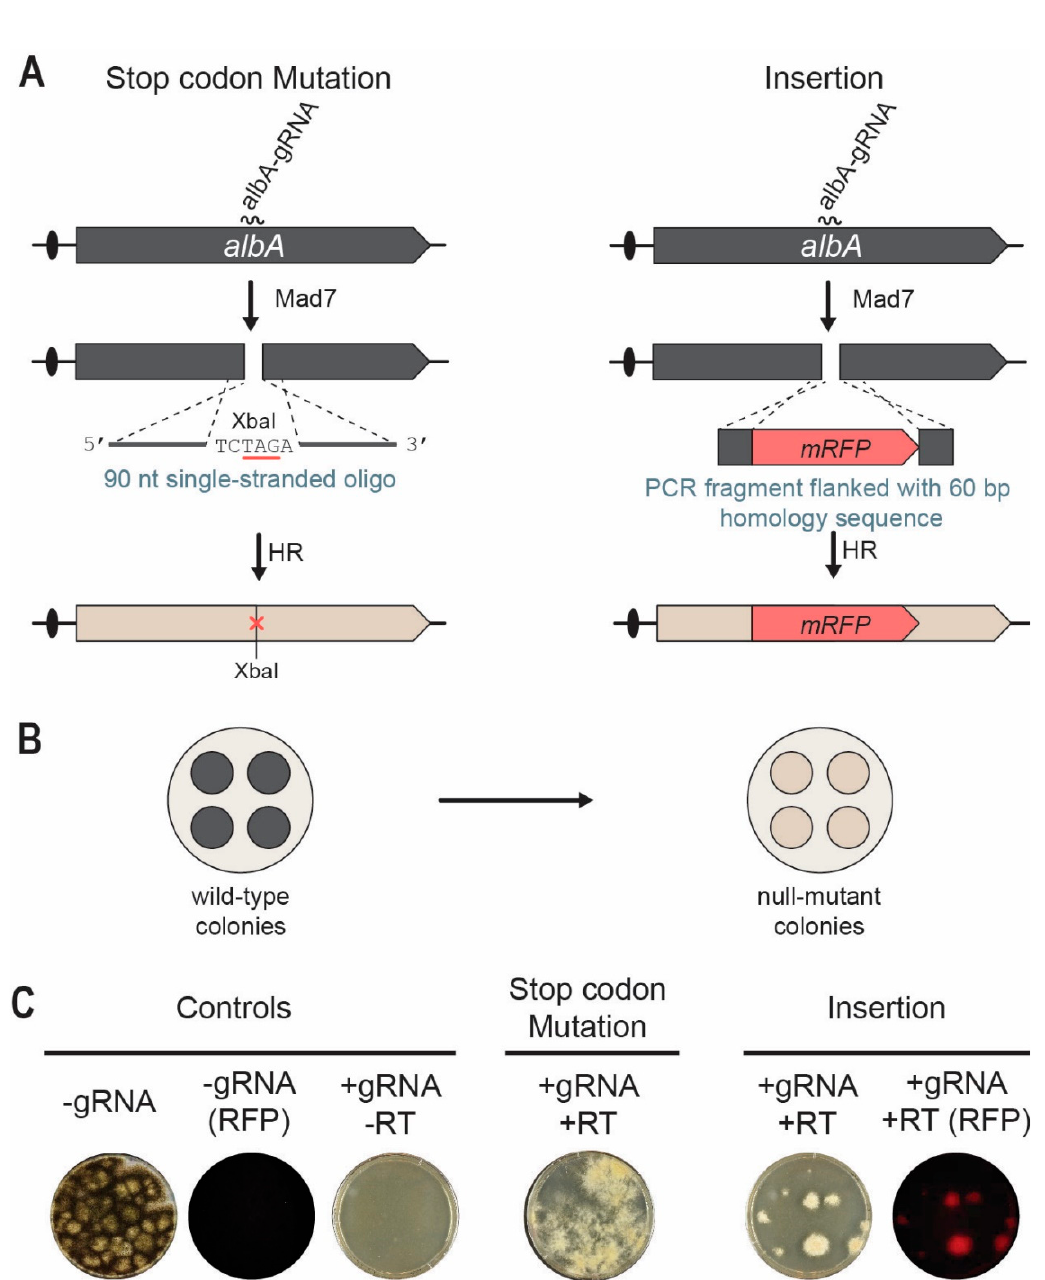
Figure 4. Mad7 ‐ induced gene editing of the albA locus in A. niger . (A) Strategies for introducing a specific XbaI site/amber stop codon into albA (left) and an mRFP insertion (right) into albA locus. A DNA DSB is introduced in albA locus by Mad7 containing an albA specific gRNA. A single ‐ stranded oligonucleotide is used as RT to direct introduction of the XbaI site/amber stop codon by HR. A PCR fragment is used as RT to direct insertion of mRFP into albA by HR. See main text for further details. (B) Mutation of albA changes the conidia color of transformants growing on solid medium from wild ‐ type black to white. (C) To the left, transformation controls with empty Mad7 ‐ CRISPR plasmid (pDIV300) imaged in visible and red fluorescent light as indicated; and with the albA ‐ Mad7 ‐ CRISPR plasmid (pDIV313) in the absence of a (RT). In the middle, introduction of a stop ‐ codon mutation into albA using the albA Mad7 ‐ CRISPR plasmid (pDIV313) and an oligonucleotide (PR_DIV3196) ‐ based RT. To the right, insertion of mRFP into albA using the albA ‐ Mad7 ‐ CRISPR plasmid (pDIV313) and the PCR ‐ based RT. Plates were imaged with visible and red fluorescent light as indicated.